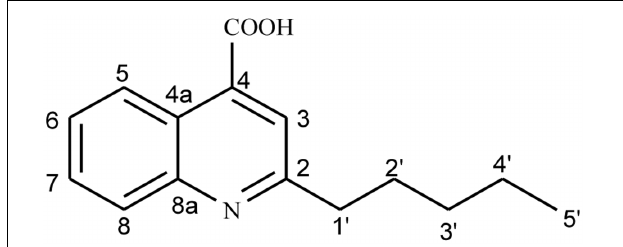
FIGURE 3 | Structure of compound 1.